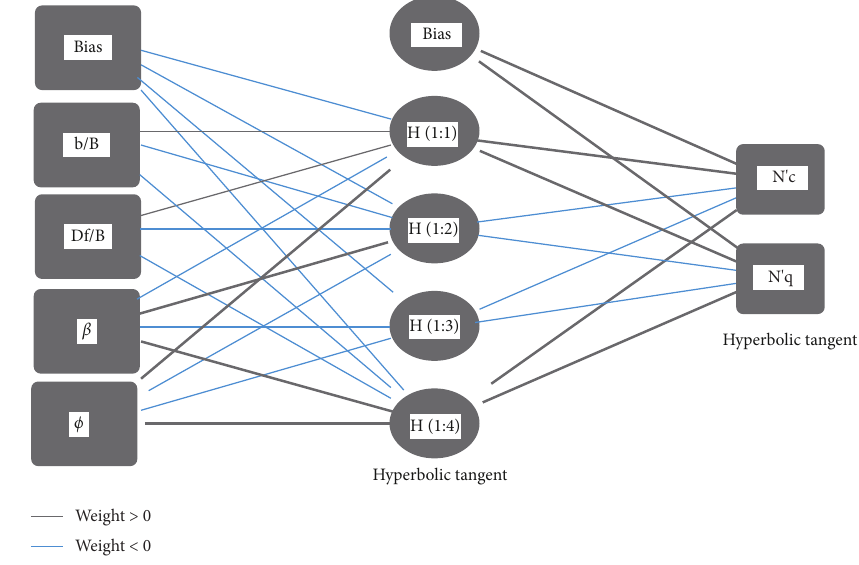
Figure 5: Layout for the developed ANN. Table 4: Connection weights of the developed ANN